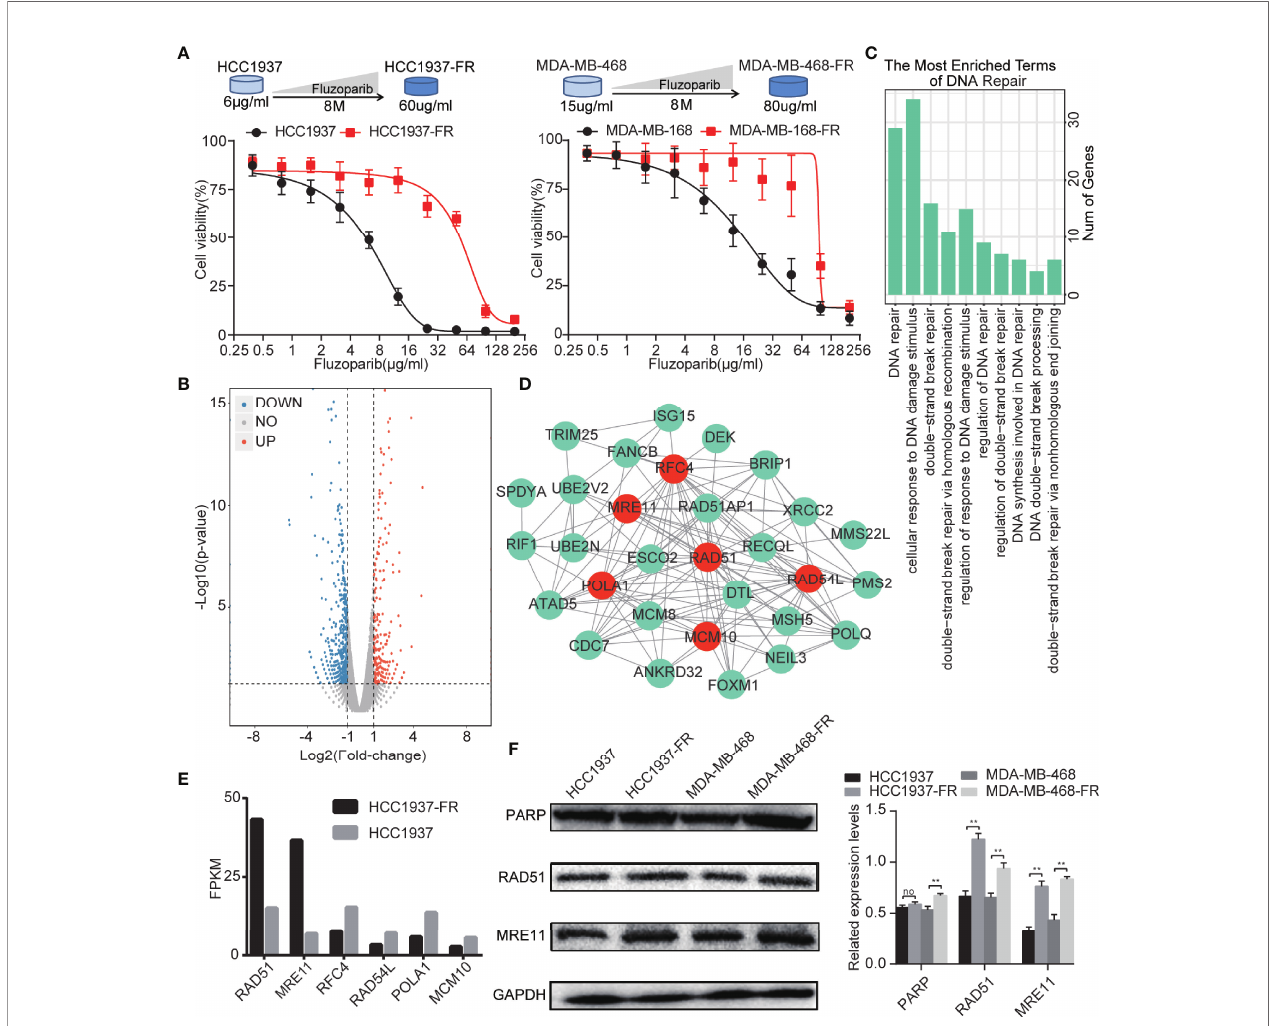
FIGURE 1 | Generation ofTNBC cells with acquired resistance to fl uzoparib andthe identi fi cation of key drugresistance genes. (A) Schematicplot of the construction of the fl uzoparib-resistant HCC1937 and MDA-MB-468 celllines. Dose-response curves of parentaland fl uzoparib-resistant HCC1937 and MDA-MB-468 cells treatedwith different concentrationsof fl uzoparib for 48 h. (B) Volcanoplot of the differential gene analysis of parental and fl uzoparib-resistant HCC1937 cells via gene sequencing. Red dots represent upregulatedgenes, andblue dots represent downregulated genes. (C) Enrichment analysis relatedto DNA damagerepair. (D) Construction of a protein – protein interaction network. The hub drugresistance genes representedby reddots had the highest gene association inthe network. (E) Gene expression levelsof hub drug resistance genes inparental and fl uzoparib-resistant HCC1937 cells. (F) Immunoblots ofRAD51, MRE11, and PARP in parental and fl uzoparib-resistant cells. Data are written as mean ± SD of three independent experiments. ** p < 0.01 compared with the parental cell group. No, nosigni fi